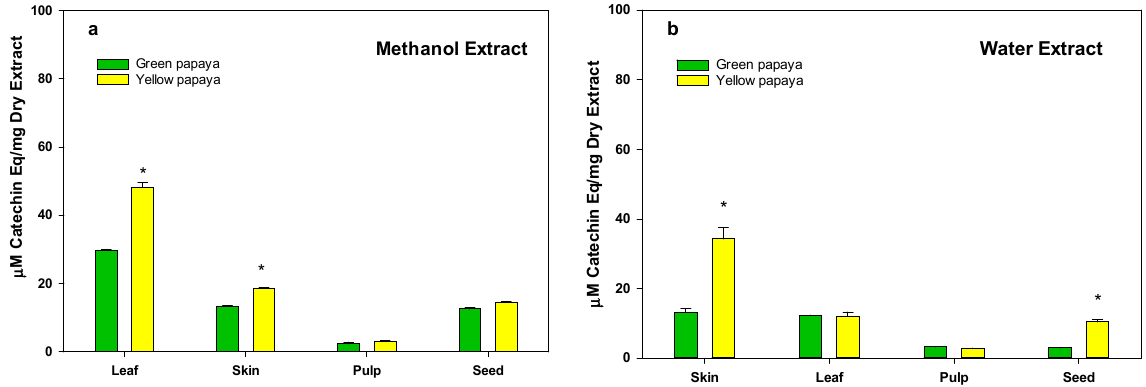
Figure 2. The total flavonoid content in green and yellow papaya. For the determination of total flavonoids, samples were nitrozalide with NaNO 2 before adding ALCl 3 , and catechin was used as the standard. The data were expressed as μ g catechin equivalent/mg dry extract. The statistical analysis was performed using Student’s t test between green and yellow papaya. The significant difference is represented by “*” at p < 0.05.